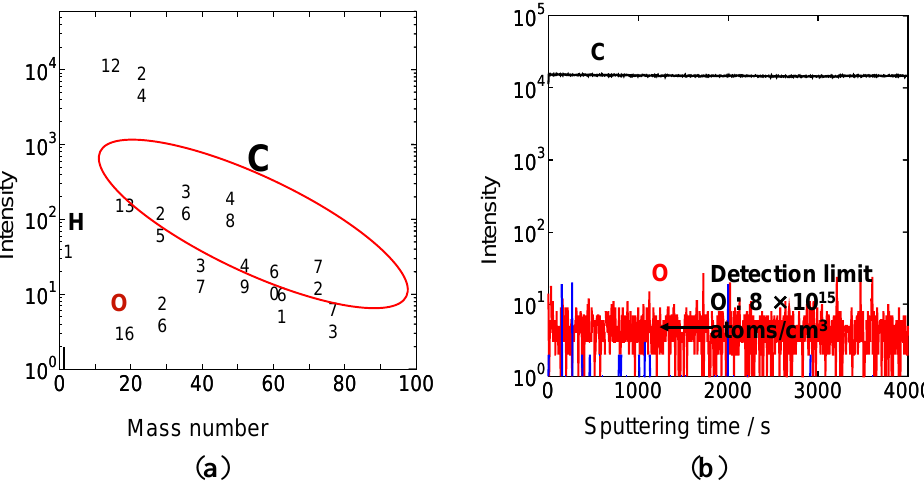
Figure 10. Negative ion mass spectrum ( a ) and depth profile ( b ) of SIMS measurements for C crystal purified three times by single-crystal 60